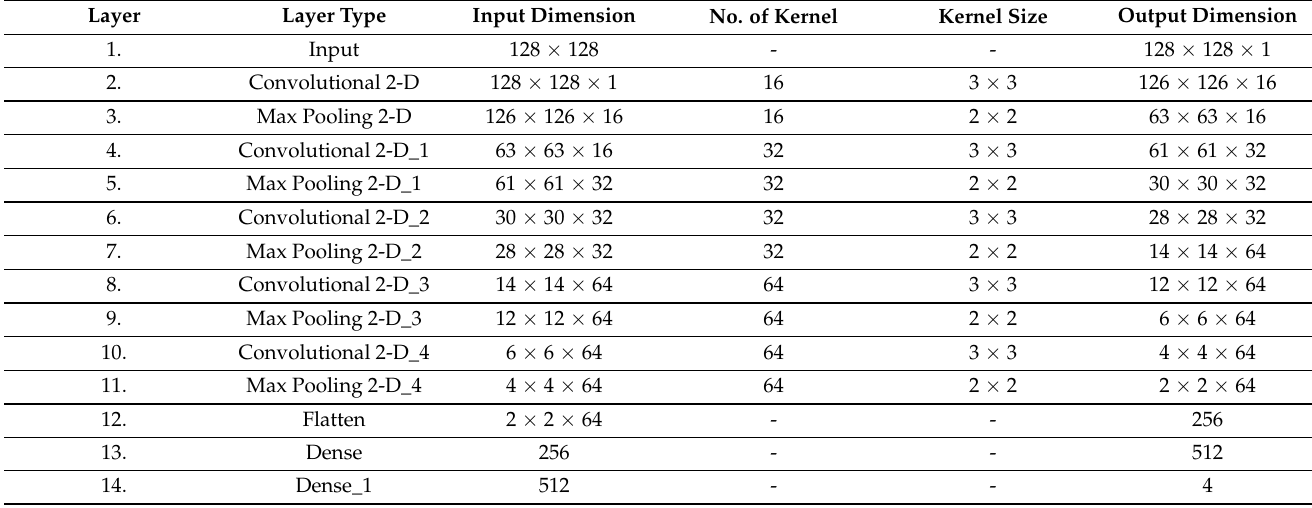
Table 2. Input and Output size after each layer of the